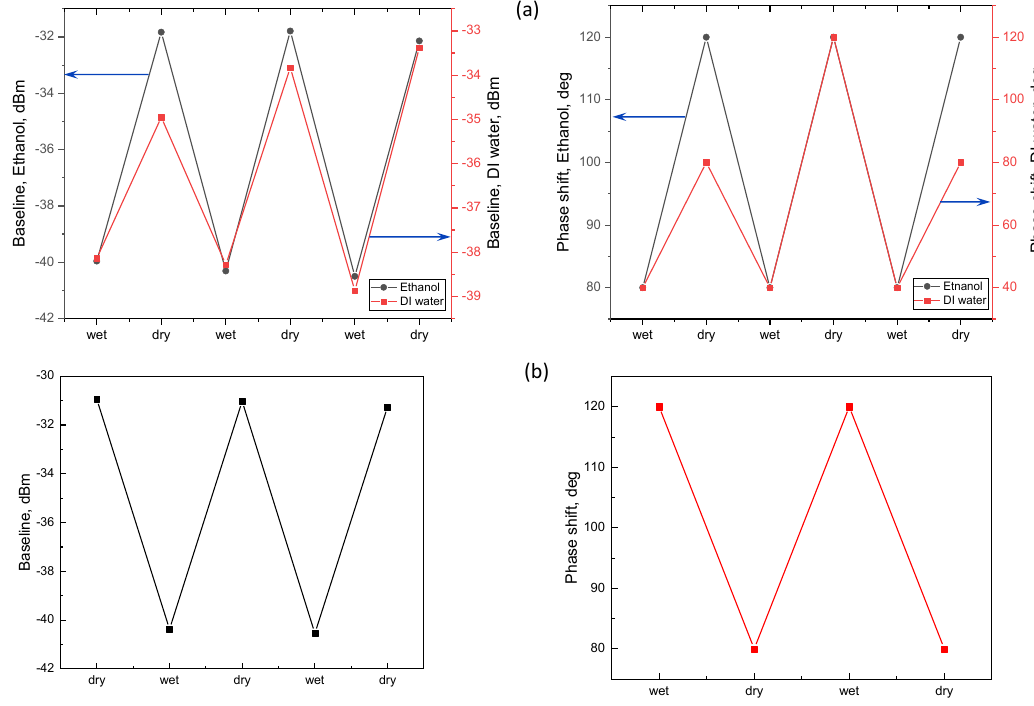
Figure 6. Fused and folded OMF exposed to subsequent wetting–drying cycles. Data series on ethanol, DI water, and 50% mixture of ethanol and methanol ( ETM ). Baseline and Phase shift as a functions of wetting/dewetting stage. ( a ) Pure liquids; ( b ) ETM